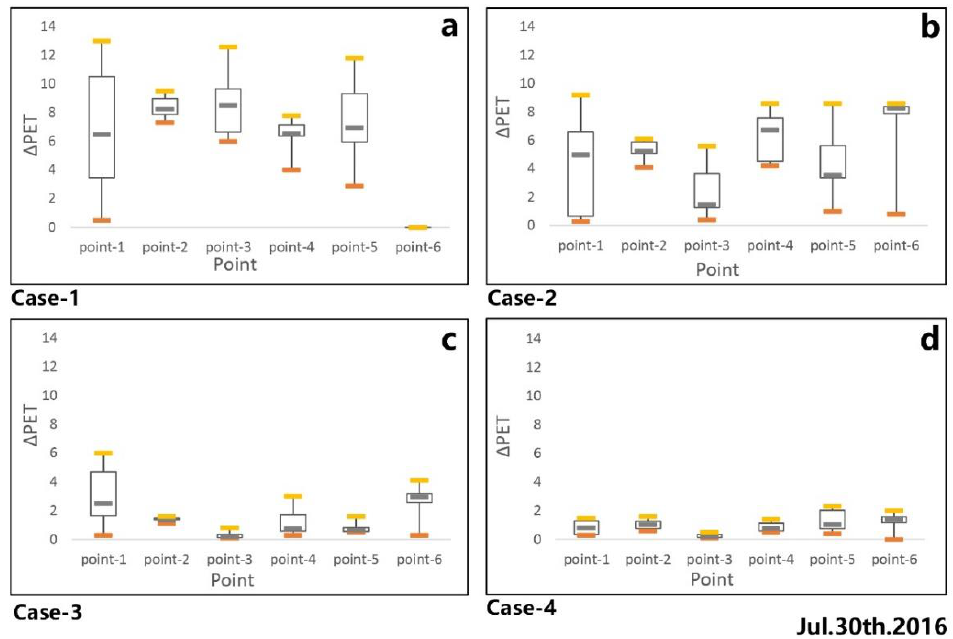
8 of 20 Figure 15. New PET distribution in different cases at 3:00 pm in the first measured day. The corresponding value and impact of different parameters is estimated as: